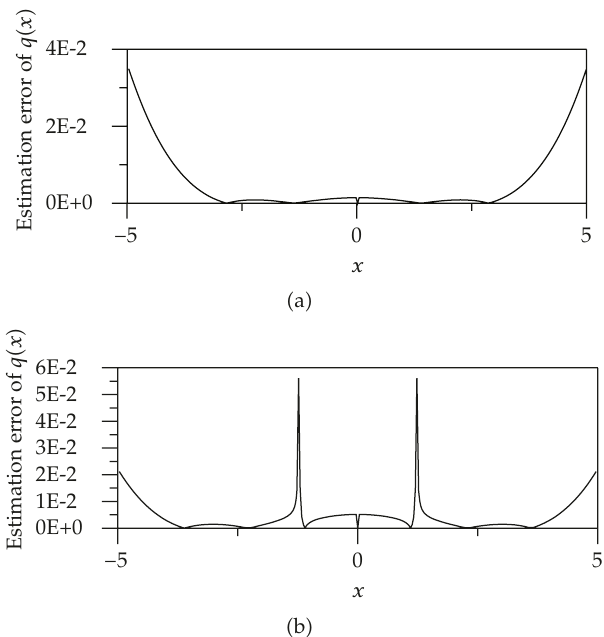
Figure 1: Example 6.1 of identifying the Schr¨odinger equation (cid:6) a (cid:7) plotting the estimation error by using the second spectral function, while (cid:6) b (cid:7) by using the fourth spectral